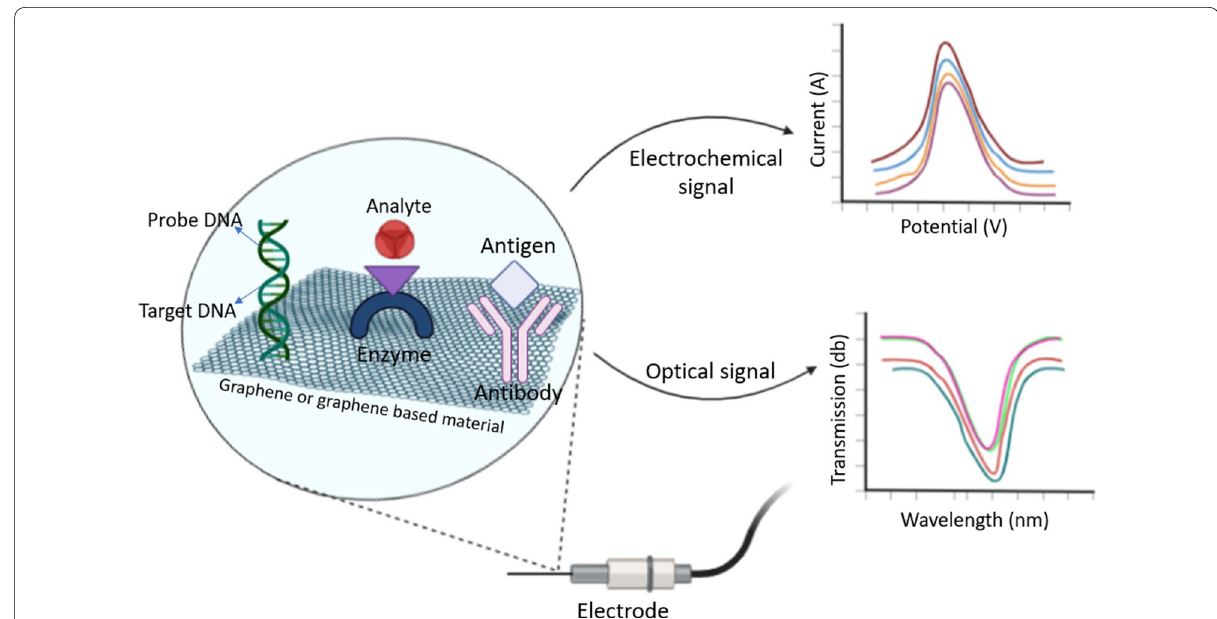
Fig. 5 Representation of graphene-based biosensors and its